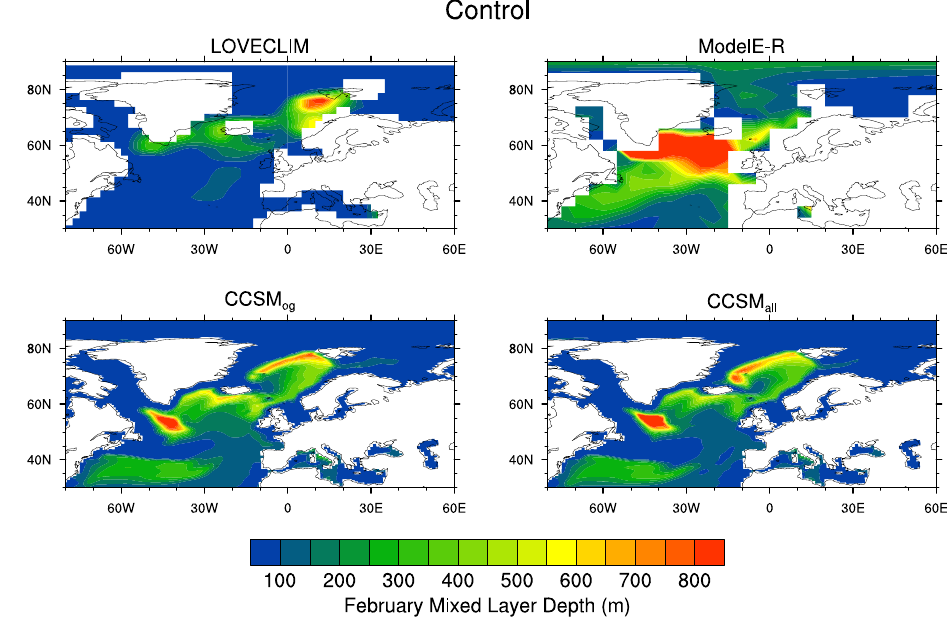
Fig. 2. Control values of February mixed layer depth, in meters. Plotted values are 100yr means.